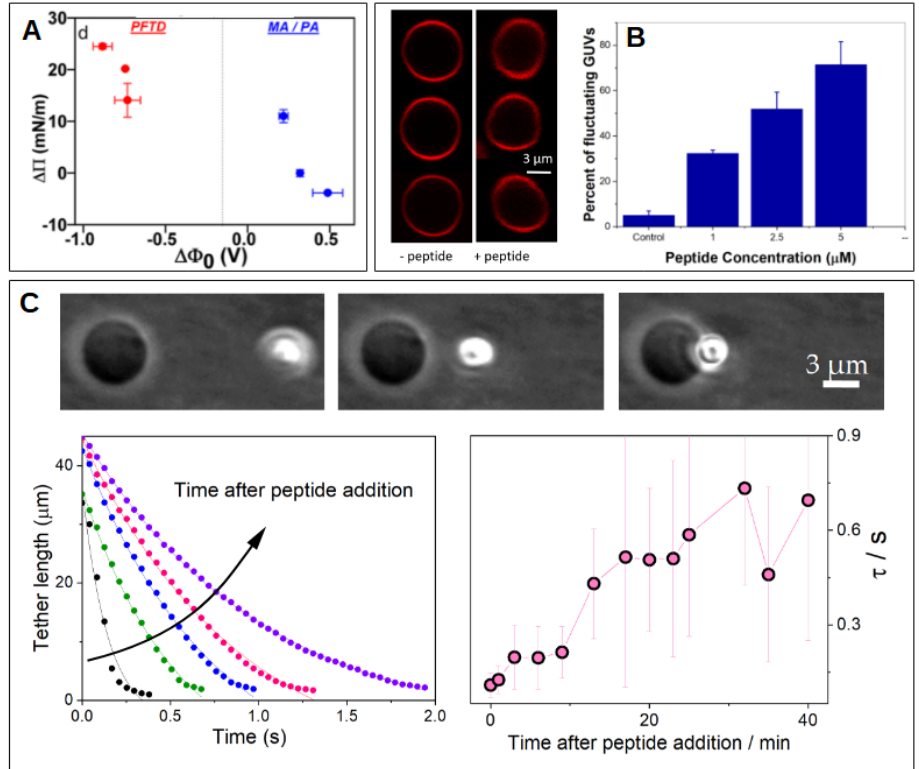
Figure 2. Peptide-membrane interaction. ( A ) Interaction of cationic peptides with lipid monolayers composed of fatty acids. The incorporation (measured as an increase in lateral pressure ∆ π ) depends on the monolayer dipole potential ( ∆Φ 0 ), and is maximal for systems with inverted (negative) values. Measurements were performed using perfluorotetradecanoic acid (PFTD), myristic acid (MA) or palmitic acid (PA). The plot is adapted with permission from [78]. Copyright (2018) American Chemical Society. ( B ) Shape fluctuations of GUVs in the presence of increasing concentration of a cationic peptide. Adapted from [82]. ( C ) Kinetic of membrane nanotube retraction formed from a GUV by means of optical tweezers. The effect of peptide addition is shown at different times. Adapted from [84] with permision from Elsevier. Copyright Elsevier